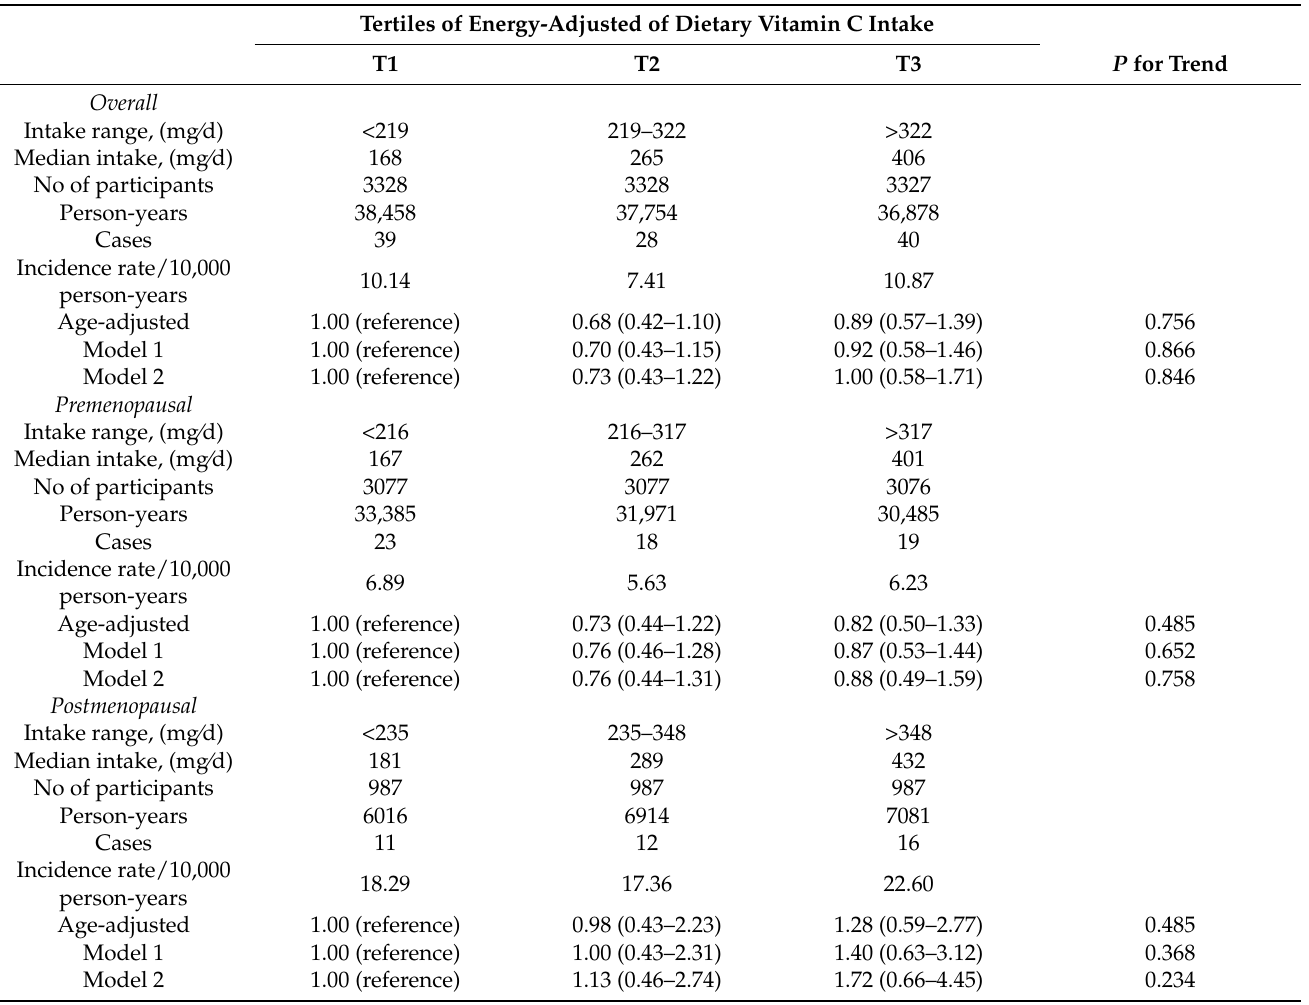
Table 3. Dietary vitamin C intake. Hazard Ratio (HR) and 95% Confidence Interval (CI) of breast cancer by tertiles of energy-adjusted dietary vitamin C at baseline among female participants of the SUN cohort. Tertiles of Energy-Adjusted of Dietary Vitamin C